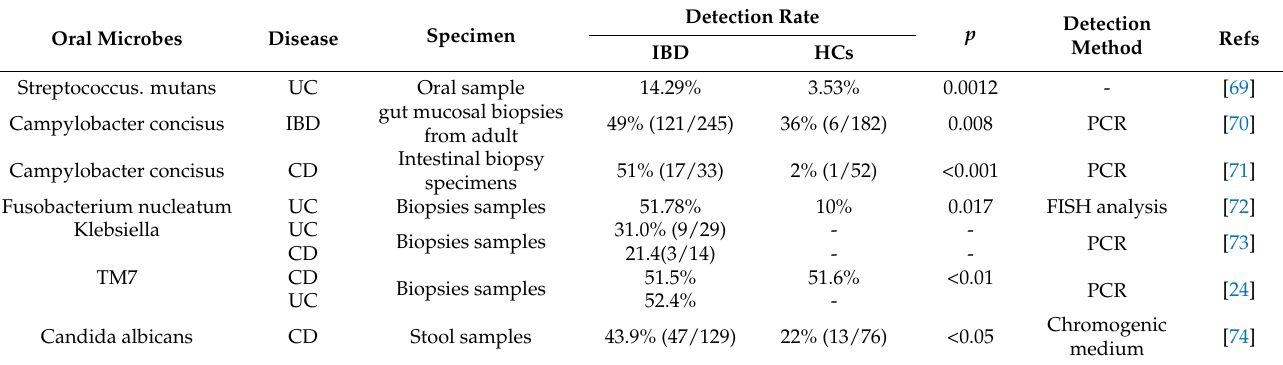
Table 2. Detection rate of oral microbes in inflammatory bowel